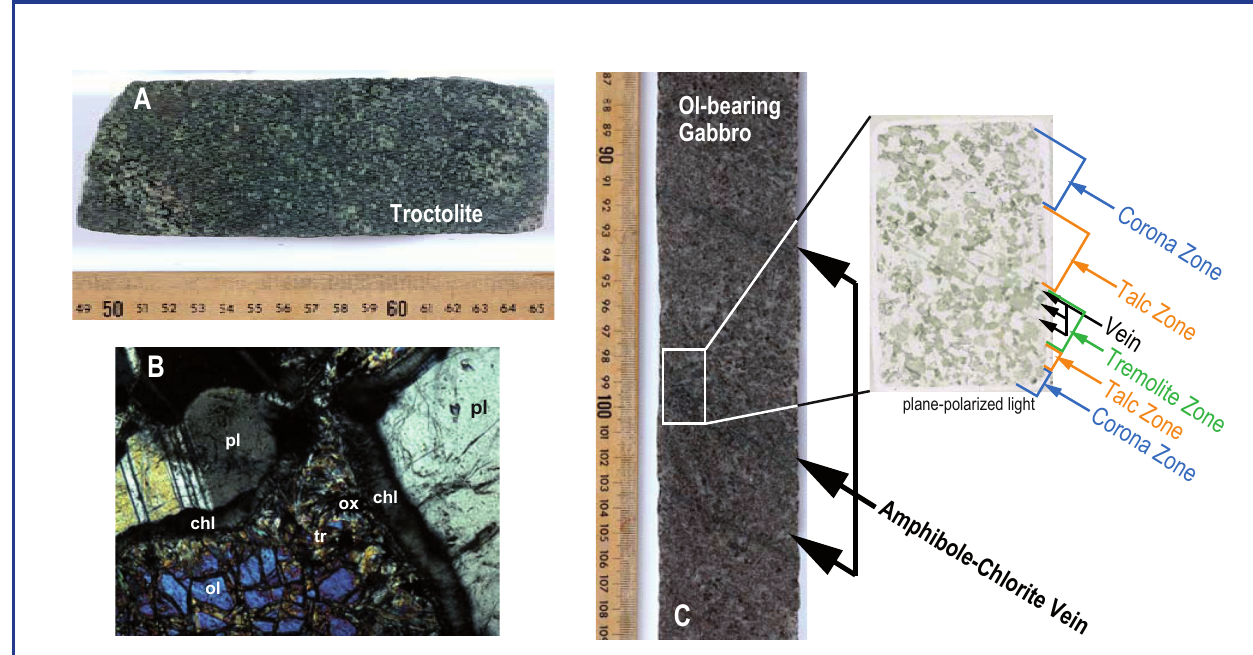
Figure 4. Most common alteration patterns. [A] Corona mesh texture in troctolite layer (Hole U1309B, ~77 mbsf). [B] Thin-section photomicrograph of a corona texture in olivine gabbro consisting of talc, tremolite, oxides after olivine, and chlorite after plagioclase where the two original minerals were in contact (Hole U1309D, ~403 mbsf, cross-polarized light, field of view ~1.4 mm). [C] Example of alteration halo around chlorite-amphibole-rich veins (Hole U1309D, ~941